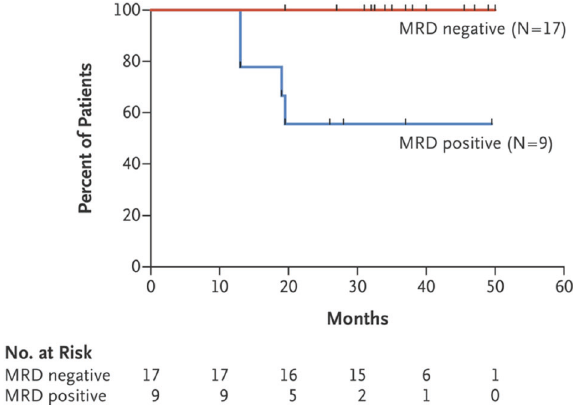
Fig. 2 Relapse-free survival by MRD status among patients treated with vemurafenib plus rituximab. (Adapted from Tiacci E, et al, NEJM,